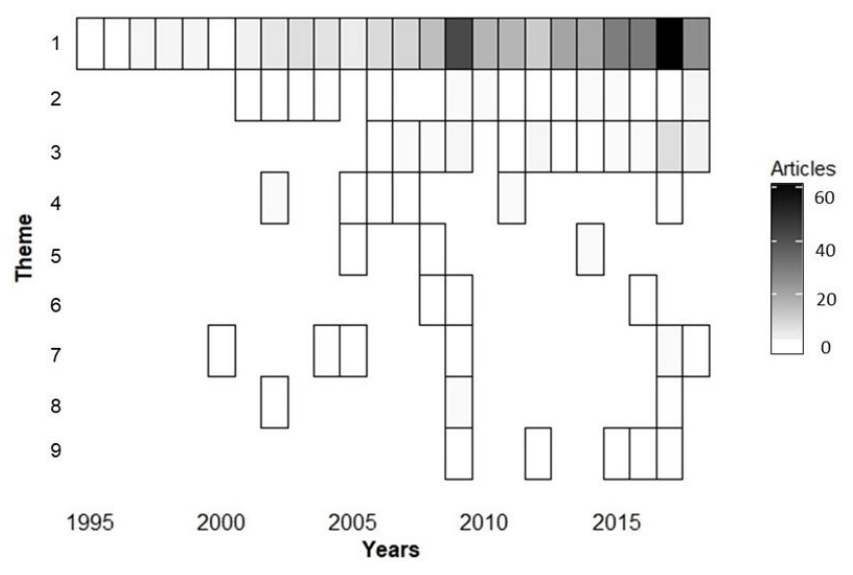
Figure 5. Number of articles with different study themes published between 1995 and 2018 found on the Web of Science (ISI) database. 1. Ecology, 2. Taxonomy, 3. Molecular, 4. Methodological, 5 Health, 6. Economics / Sociology, 7. Geology, 8. Limnology, 9. Others (Paleolimnology,